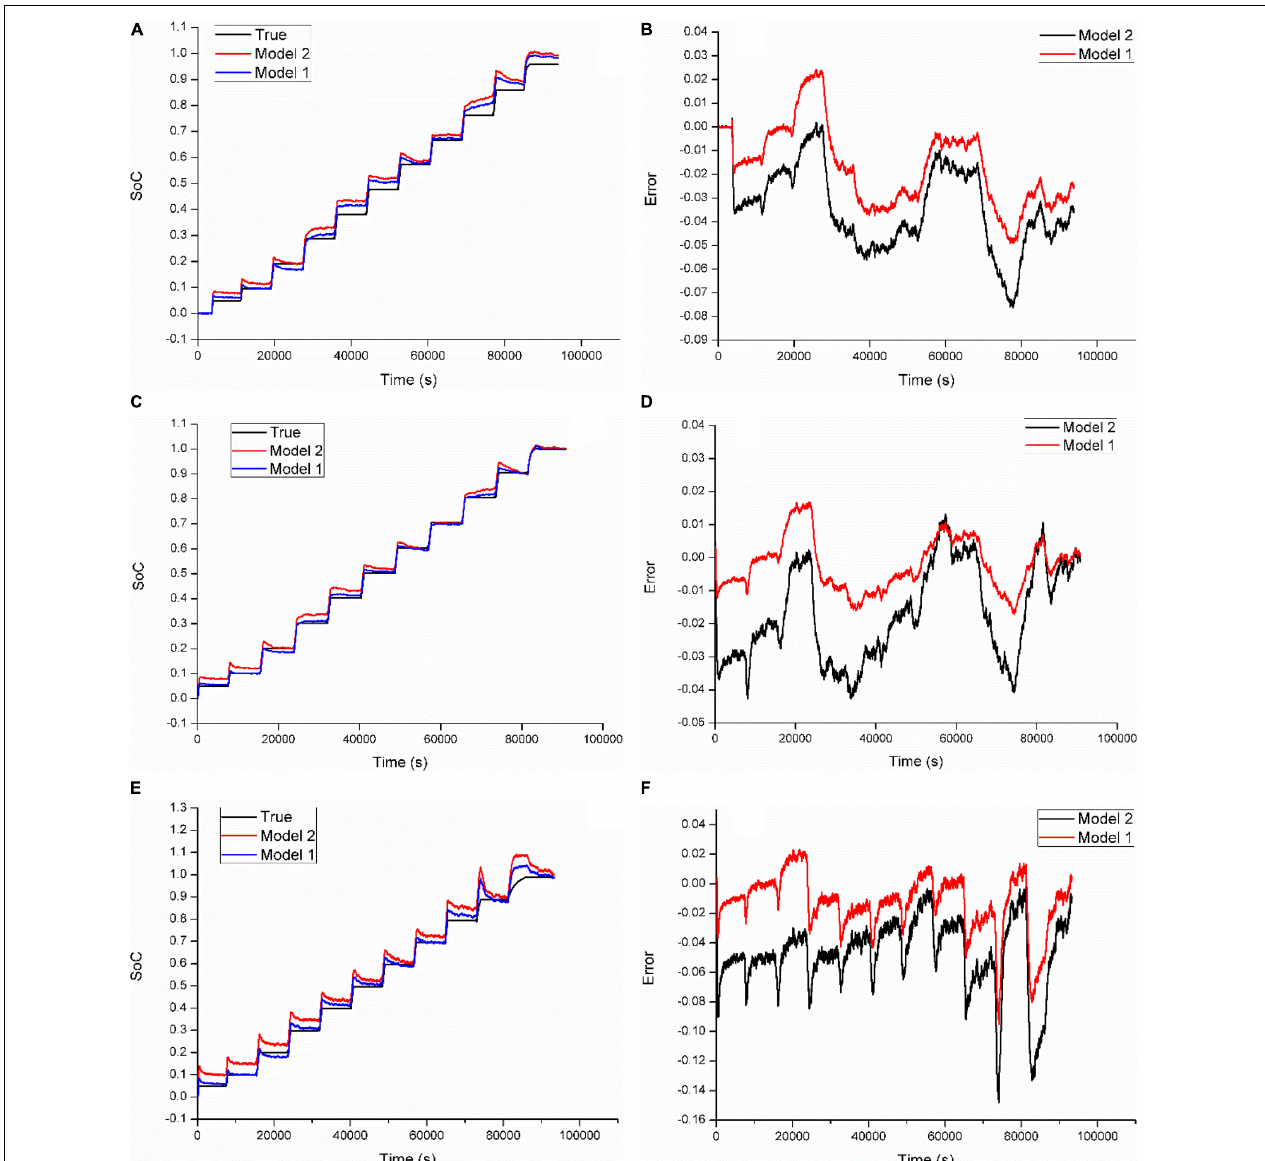
FIGURE 12 | Estimation results based on model 1 and model 2 at three temperatures via the RHPPC. (A) Estimated SoCs at 40 ◦ C; (B) estimation errors at 40 ◦ C; (C) estimated SoCs at 22 ◦ C; (D) estimation errors at 22 ◦ C; (E) estimated SoCs at 0 ◦ C; (F) estimation errors at 0 ◦ C.